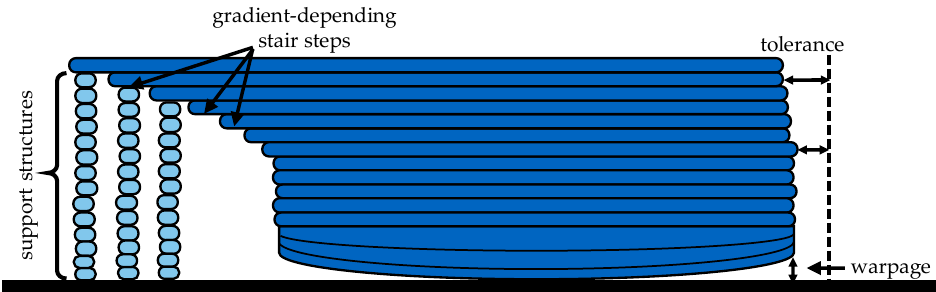
Figure 2. Challenges of additive manufacturing using the example of FDM printing.